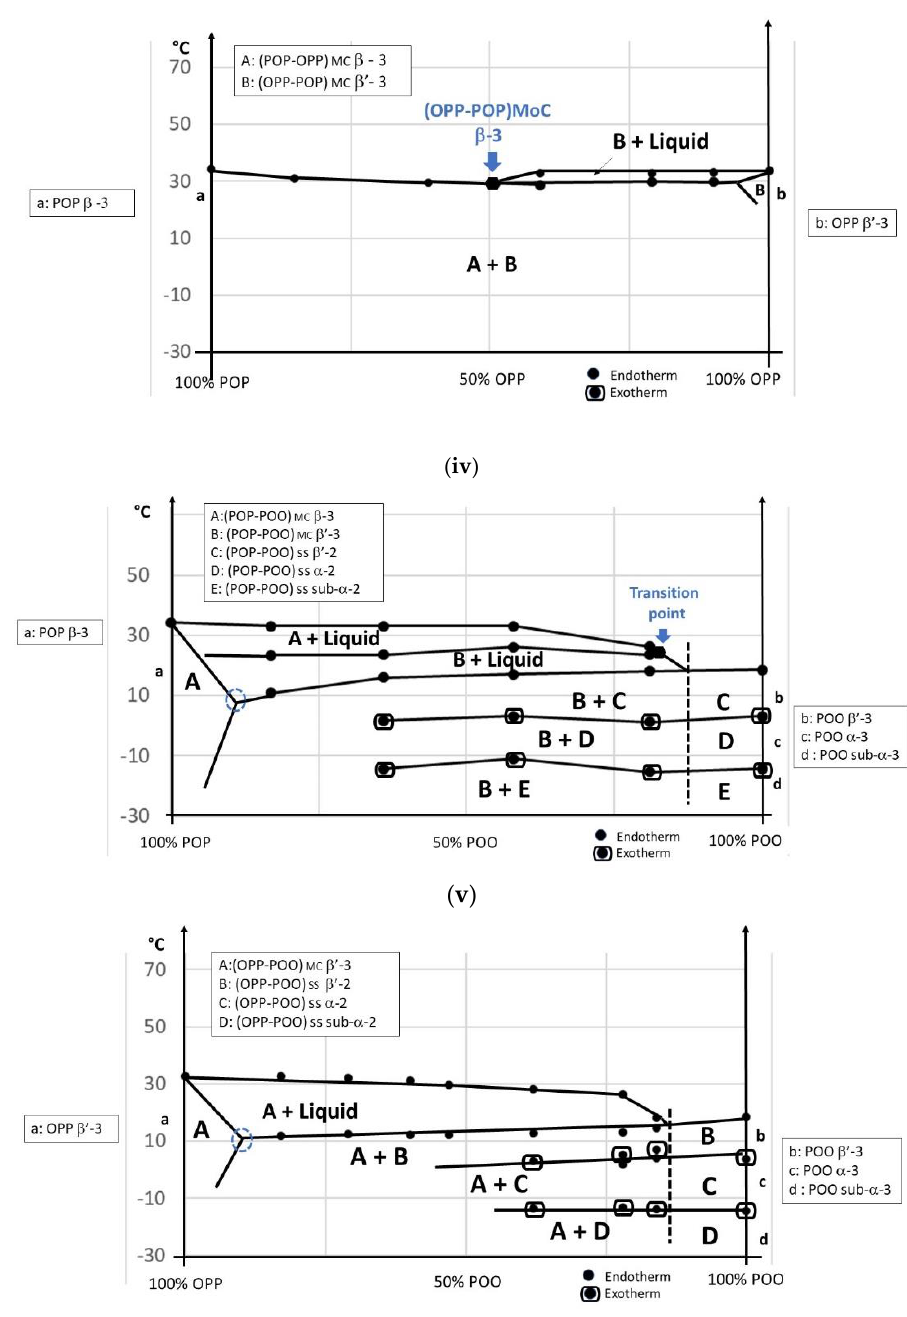
Figure 5. ( i ) (PPP-POP) phase diagram; ( ii ) (PPP-OPP) phase diagram; ( iii ) (PPP-POO) phase diagram; ( iv ) (POP-OPP) phase diagram; ( v ) (POP-POO) phase diagram and ( vi ) (OPP-POO) phase diagram, in tempered mode. SS: solid solution; MC: mixed crystal; MoC: molecular compound. PPP / PPP/OPP